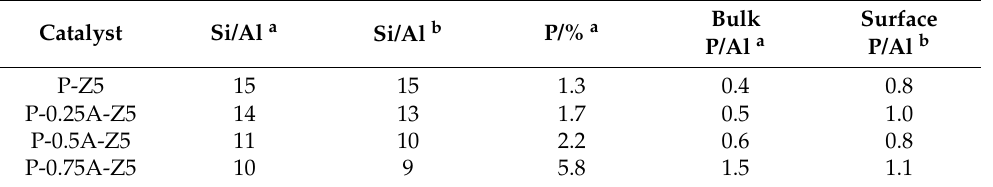
Table 5. Chemical compositions of the